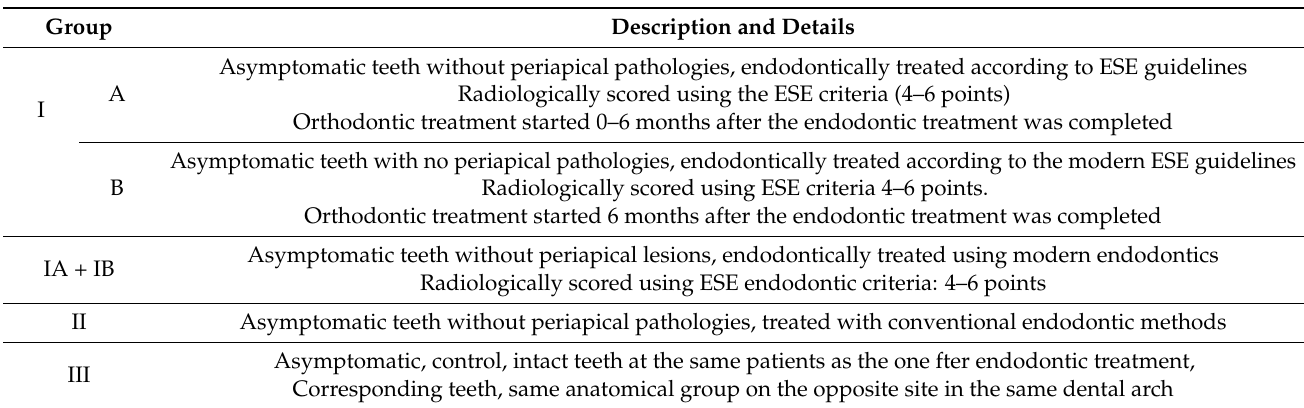
Table 1. Characteristics of participants’